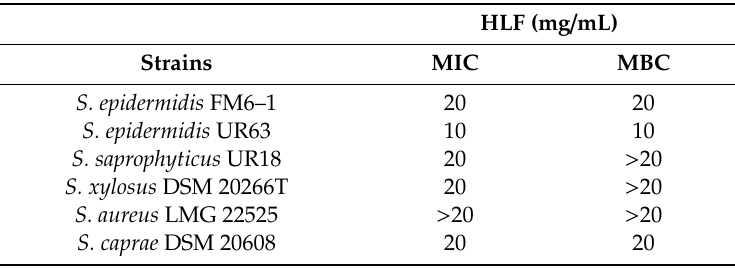
Table 1. Minimal inhibitory concentration (MIC) and minimum bactericidal concentration (MBC) of bovine lactoferrin hydrolysate (HLF) registered against selected Staphylococcus spp. (forming a biomass of biofilm higher than 0.4, as OD λ = 570 nm ) after 48 h of